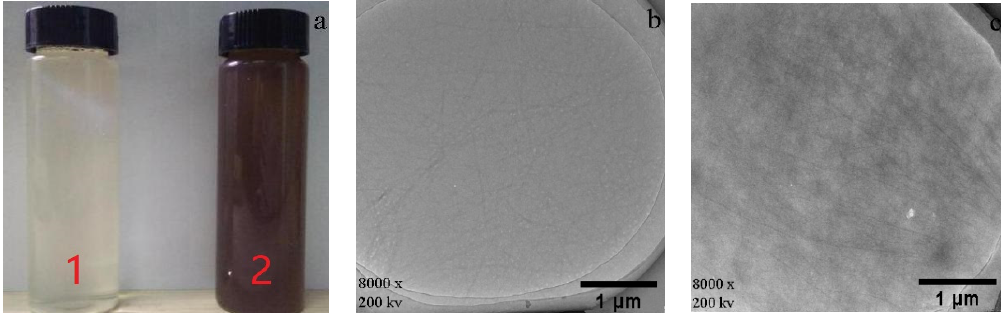
Figure 1. Visual appearance and TEM of fibrils prepared from WPI-1 and WPI-2 ( a1 ): appearance of WPI-1 (without lecithin) fibril solution; ( a2 ) appearance of WPI-2 (with lecithin) fibril solution; ( b ) TEM of WPI-1 fibrils; ( c ) TEM of WPI-2 fibrils. The TEM results for WPI-1 (protein mass fraction of 97.80%, without lecithin) and WPI-2 (protein mass fraction of 90.39%, containing lecithin) fibrils are shown in Figure